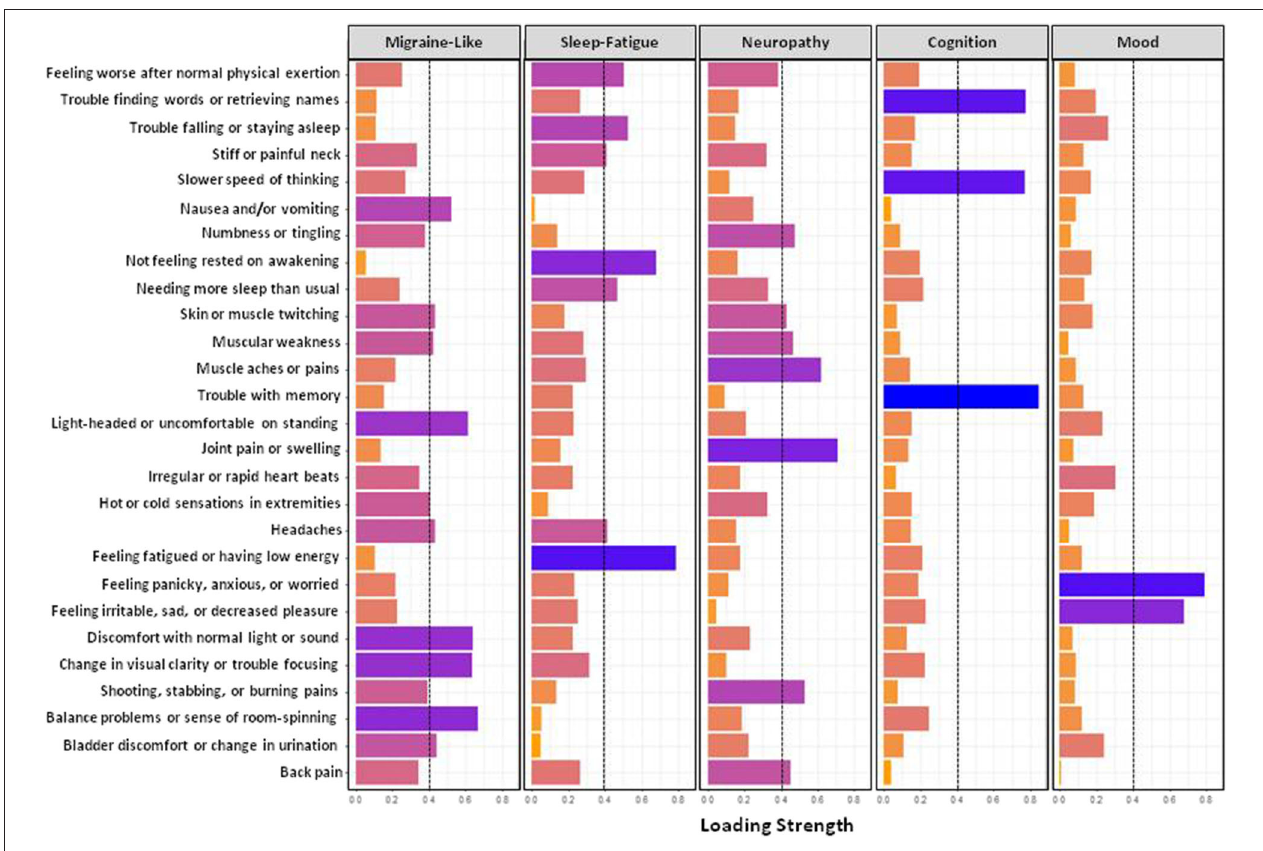
FIGURE 1 | Exploratory factor analysis using scores on the GSQ-30.